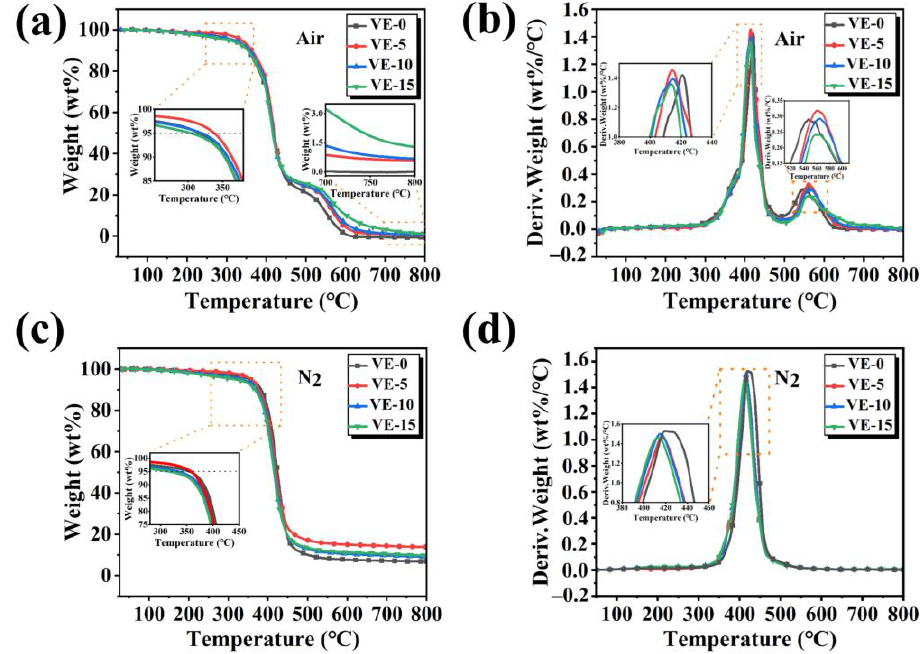
Figure 5. TGA and DTG curves of VE composites in air ( a , b ) and N 2 ( c , d ).